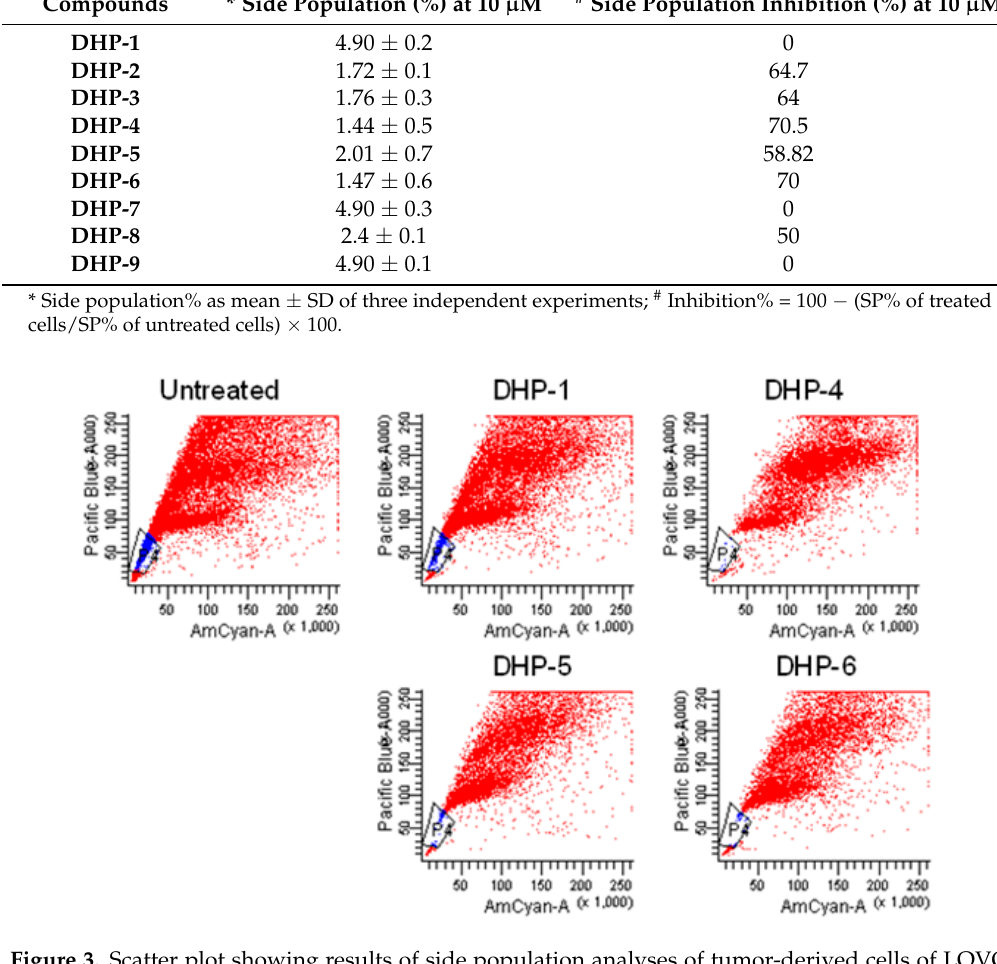
Table 2. Side population inhibition on LOVO colon cancer cells (%) at 10 μ M concentration. Compounds